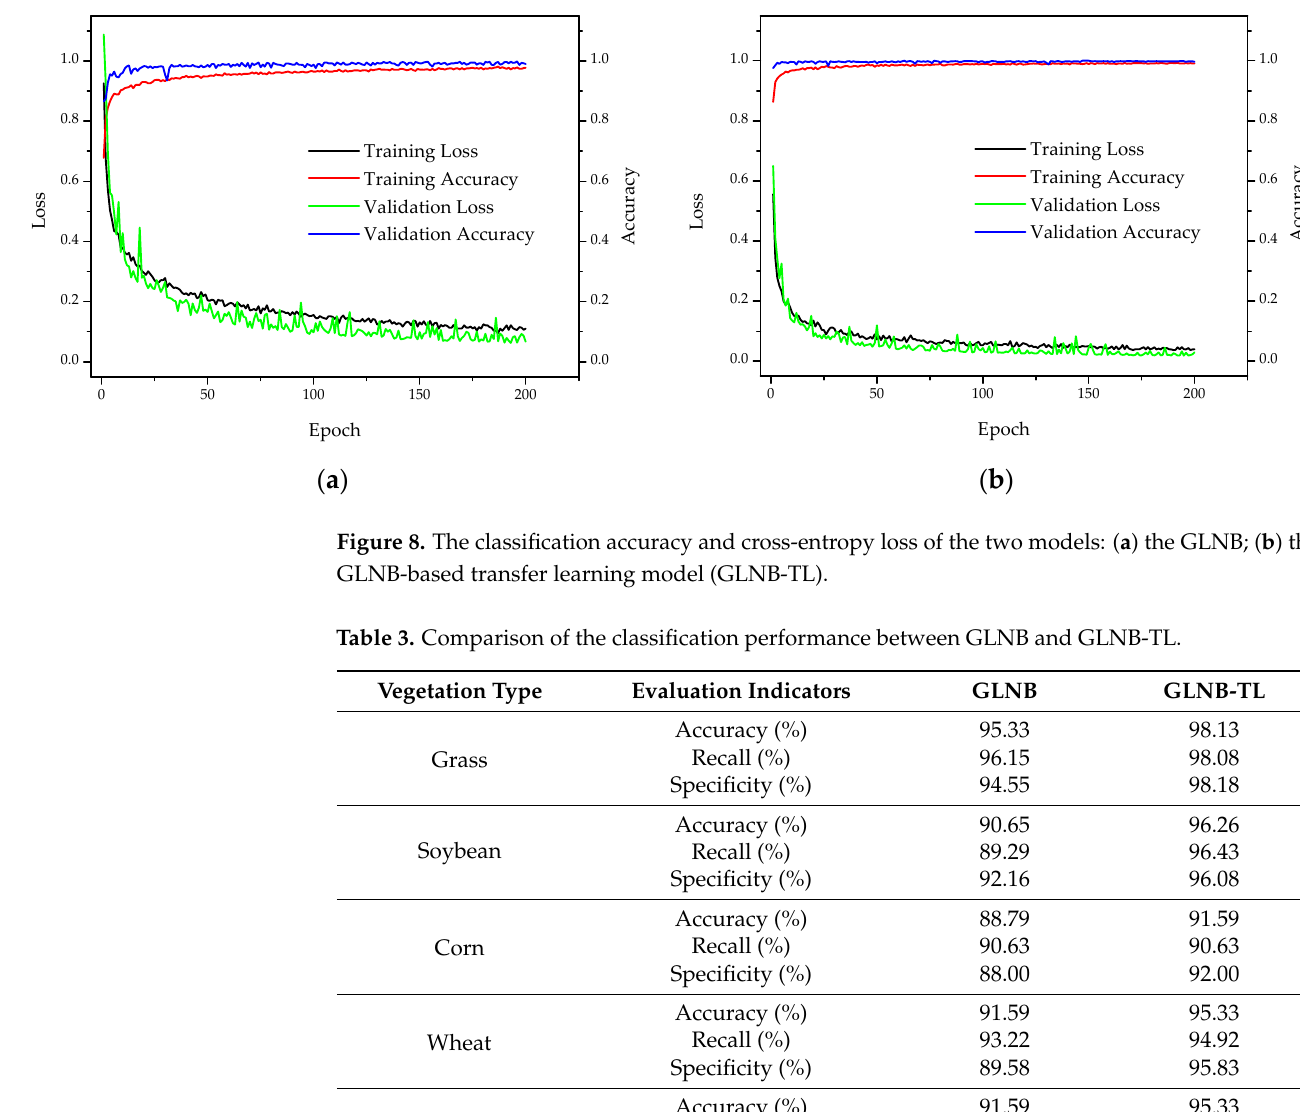
Table 3. Comparison of the classification performance between GLNB and GLNB-TL.